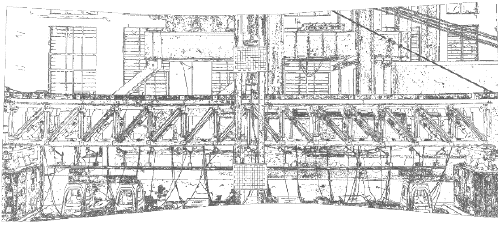
Figure 15. Feature points of test beam.